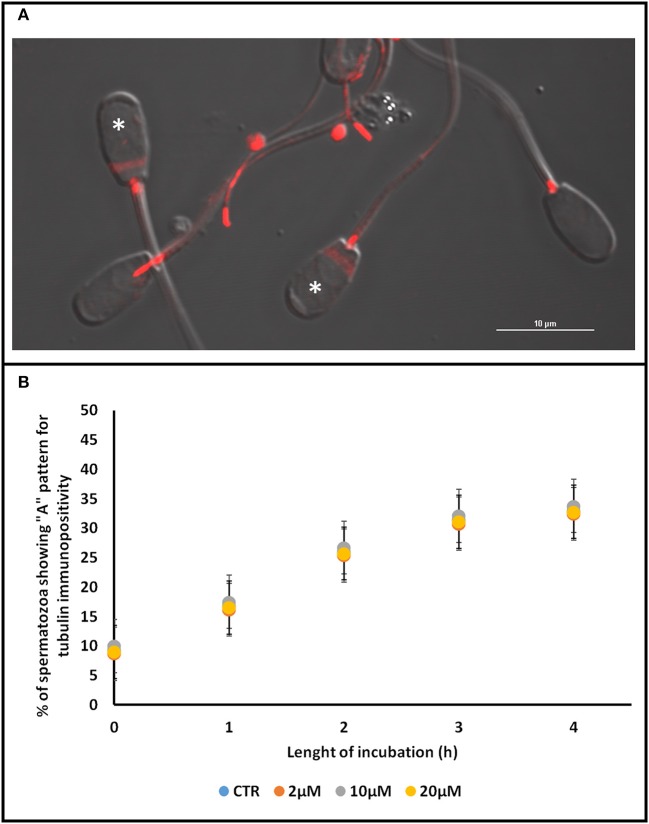
Effect of Aminopurvalanol A on tubulin subcellular localization. In (A) are shown the two different patterns of tubulin immunopositivity localization found. In (B) the percentage of spermatozoa displaying pattern B, at different incubation times, are reported. For each time point no significative differences were found. The data are represented as mean±satndard deviation, and the comparison were carried out by ANOVA two ways followed by Tukey's post-hoc test. See Table 2 for the results of statistical analysis. *Denotes spermatozoa displaying Pattern A.